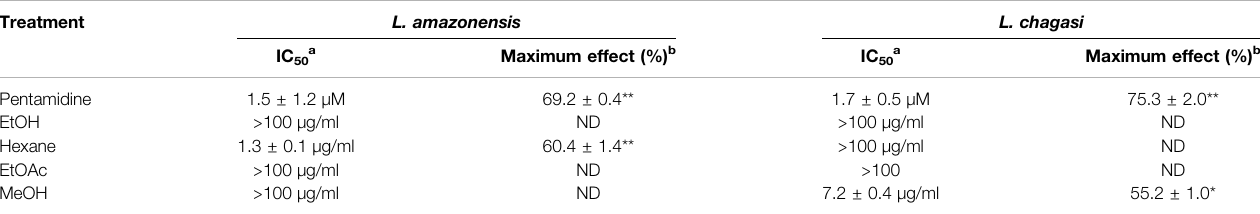
TABLE 4 | Effects of pentamidine, EtOH extract; hexane, EtOAc, MeOH fractions of propolis from the semi-arid region of Bahia, Brazil, against amastigote forms of L. amazonensis and L. chagasi . Treatment